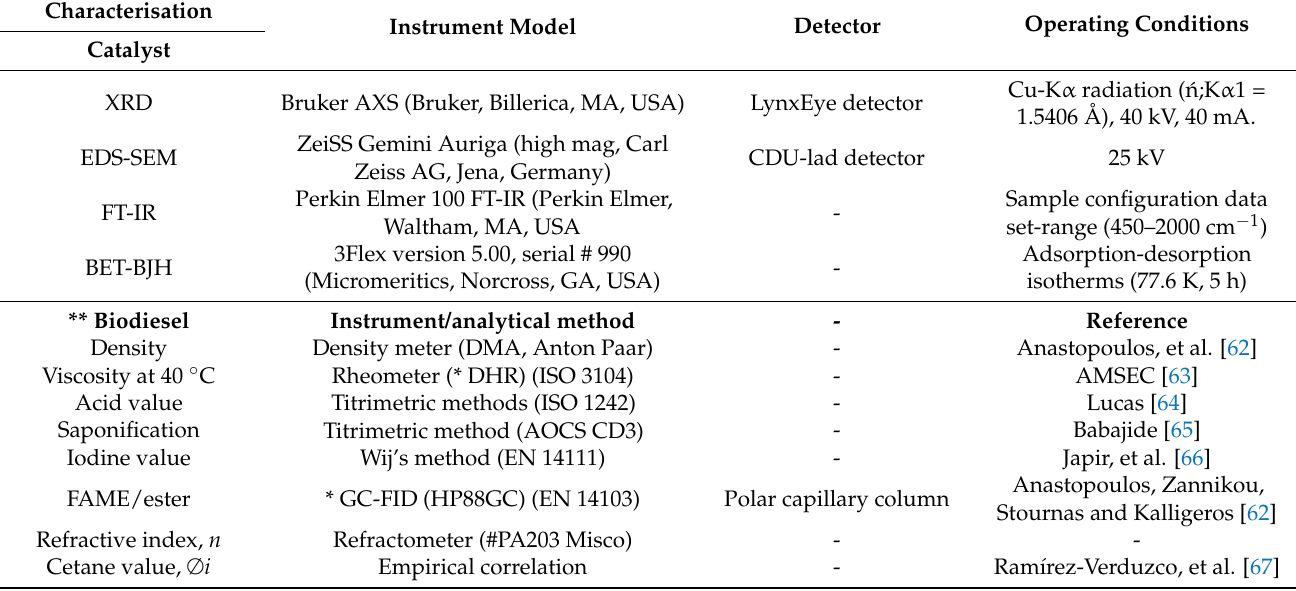
Table 6. Characterization of catalyst and biodiesel samples (instruments, operating